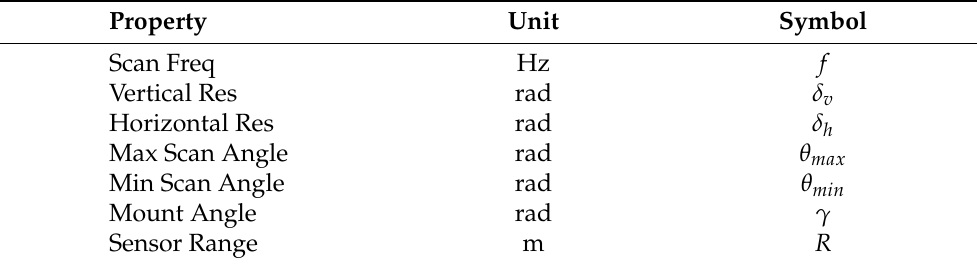
Table 2. Sensor properties used in this analysis.